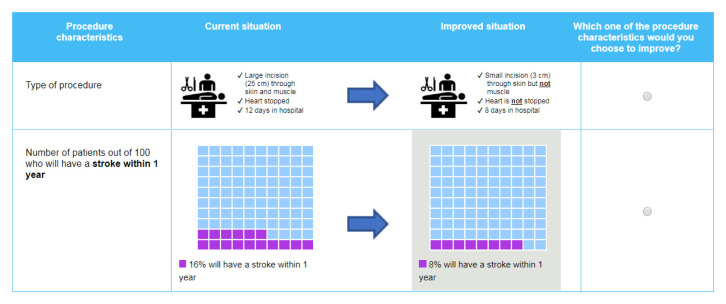
Example adapted swing weighting question presented to study participants.
‘Type of Procedure’ was used in every pairwise comparison. Only the comparison attribute was varied across different attributes and performance levels.